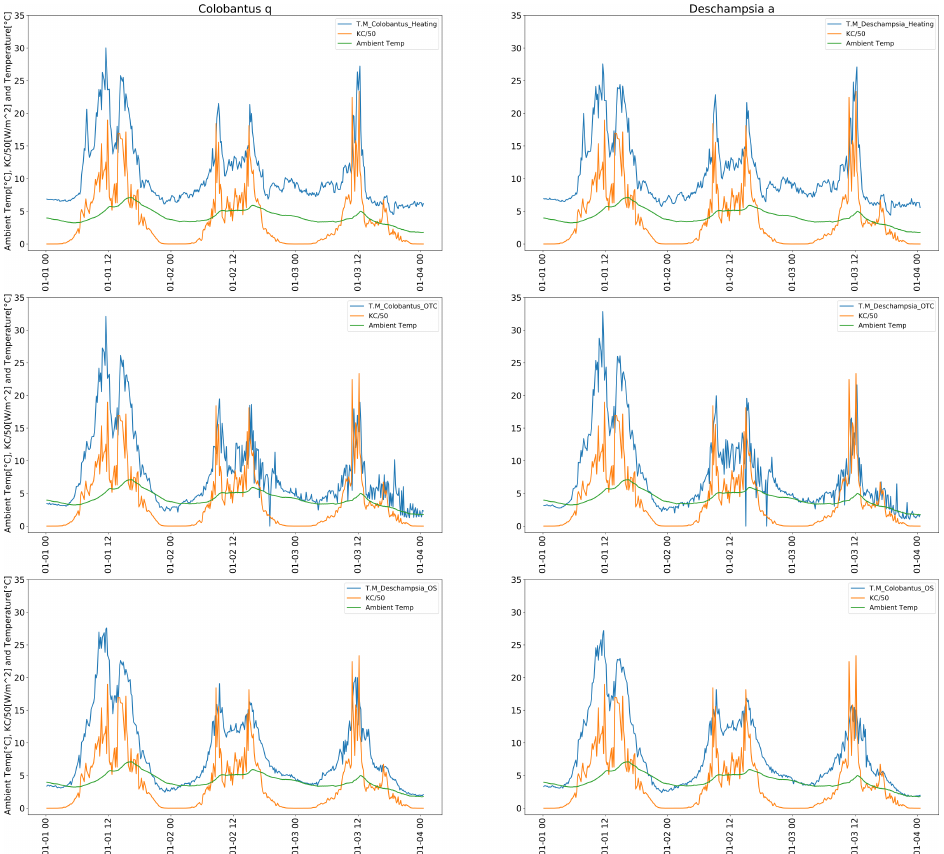
Figure 13. Time series of leaves temperature, segmented by species and group, together with solar radiation and ambient temperature measured by automatic weather station in a period of 1–4 January 2021.